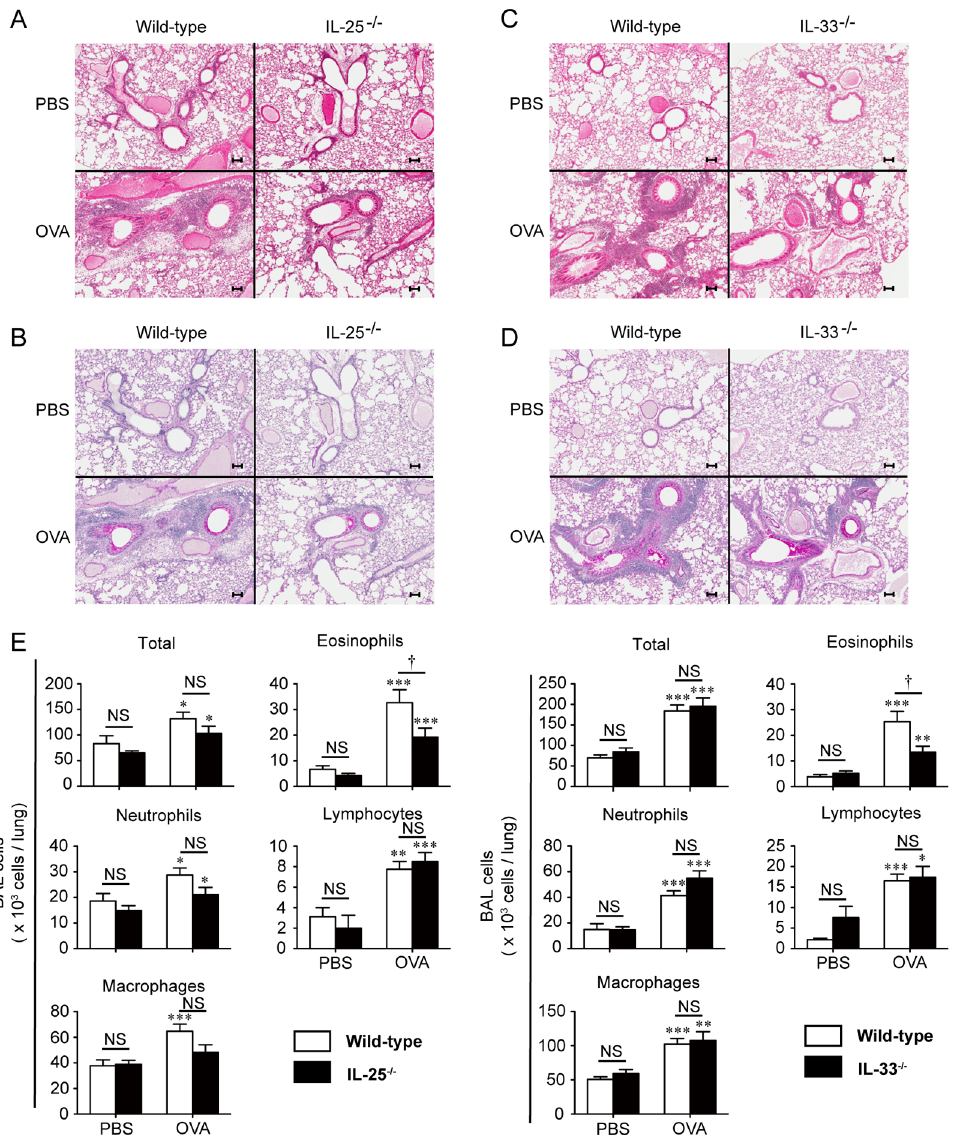
Fig 3. IL-25 and IL-33 are crucial for development of airway eosinophilia, but not neutrophilia, after the last intranasal OVA challenge in mice sensitized epicutaneously (EC) with OVA. Mice were sensitized EC with OVA three times and then treated intranasally with OVA or PBS for 3 consecutive days. Twenty-four hours after the last inhalation of OVA or PBS, BALFs and lungs were collected. (A, B) Lung sections from wild-type (WT) and IL-25 -/- mice were stained with hematoxylin-eosin (H-E) (A) and PAS (B). (C, D) Lung sections from WT and IL-33 -/- mice were stained with H-E (C) and PAS (D). Scale bars = 100 mm. The data show representative results from 10 – 14 mice in each experimental group, as indicated. (E) The numbers of BAL cells from WT (PBS, n = 8; OVA, n = 24) and IL-25 -/- mice (PBS, n = 8; OVA, n = 28), and from WT (PBS, n = 10; OVA, n = 20) and IL-33 -/- mice (PBS, n = 11; OVA, n = 20). Data are pooled from three independent experiments, each of which gave similar results. Data show the mean + SEM (E, F). * P < 0.05, ** P < 0.01 and *** P < 0.001 vs. the corresponding values for PBS-treated mice. † P < 0.05 and NS (not significant) vs. the indicated group (WT vs. IL-25 -/- , or WT vs. IL- 33 -/-